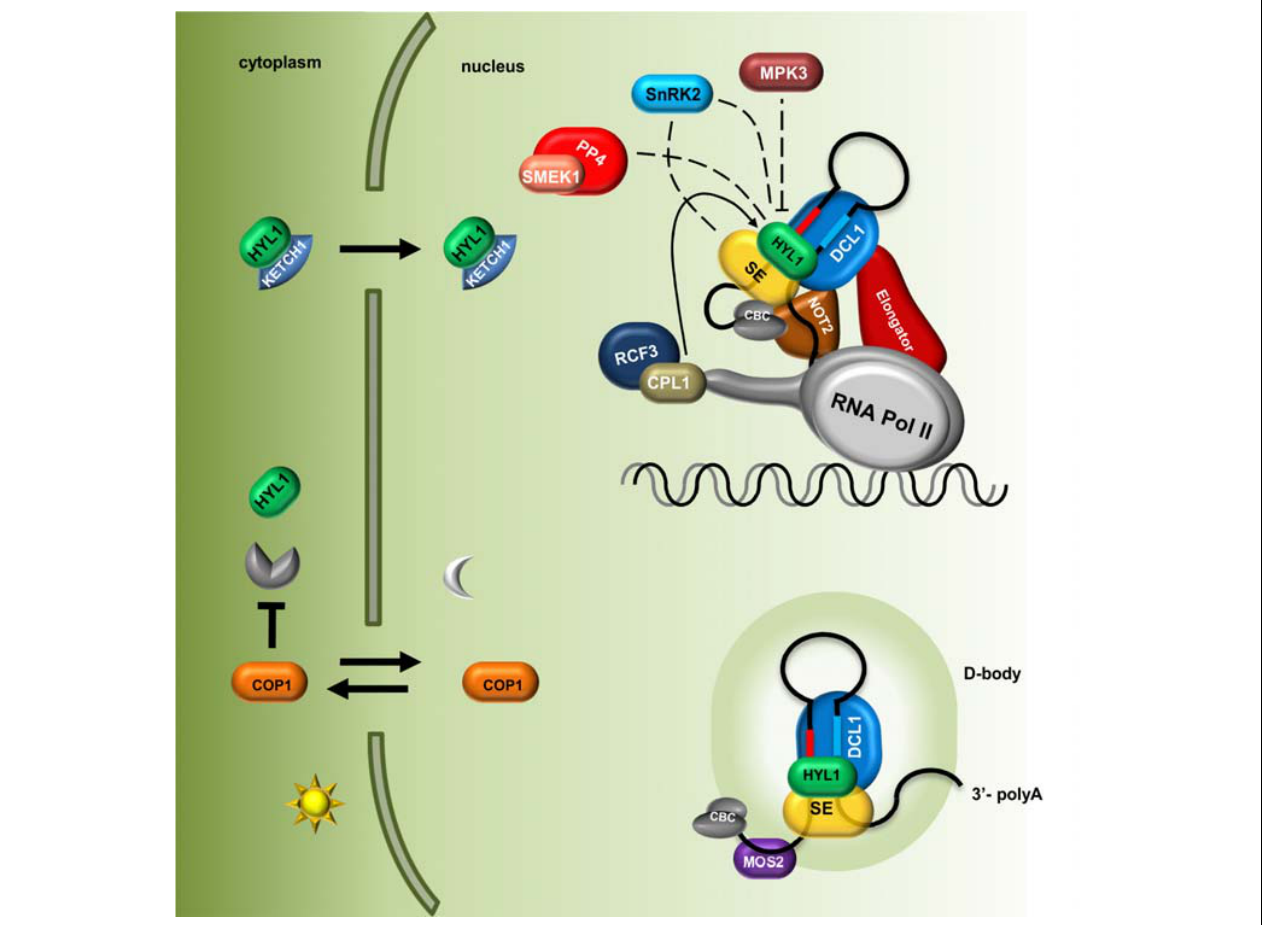
FIGURE 1 | Plant microRNA biogenesis is fine-tuned via regulation of Microprocessor components localization and their post-translational modifications. The level of HYL1 in the cytoplasm is indirectly regulated by COP1 in a light-dependent manner; HYL1 nuclear import is mediated by KETCH1 importin. Core components of the Microprocessor: DCL1, SE and HYL1 as well as microRNA precursors are located and interact with each other in the D-bodies. MOS2 is important for the D-bodies assembly however, does not interact directly with the Microprocessor. The Elongator complex and NOT2 proteins form a bridge coupling transcription and processing of microRNAs. Phosphorylation status of HYL1 is crucial for its efficient function and is a consequence of an interplay between kinases (MPK3 and SNRK2) and phosphatases (CPL1 and PP4). Direct influence of SnRK2 on SE and HYL activity is not known. CBC, nuclear Cap Binding Complex; dashed lines indicate that exact localization of the interactions is